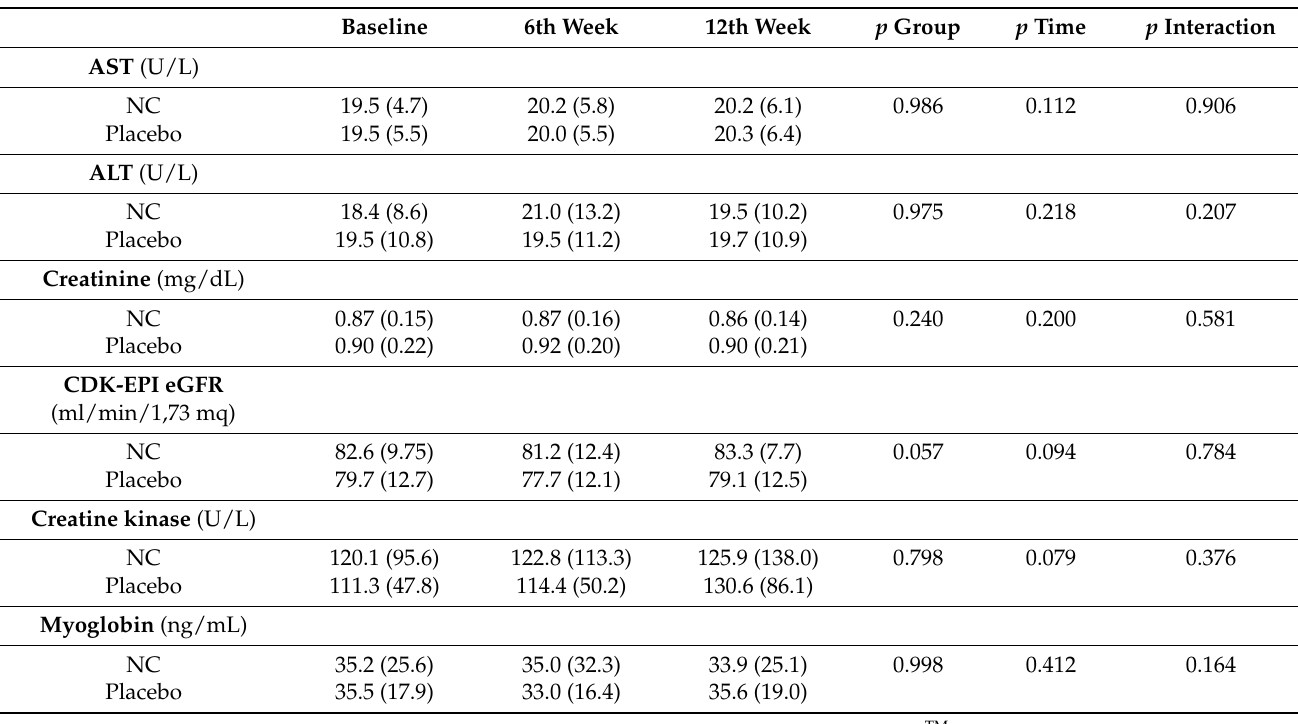
Table 2. Baseline and 6- and 12-week’s levels in safety parameters in participants who completed the study by group